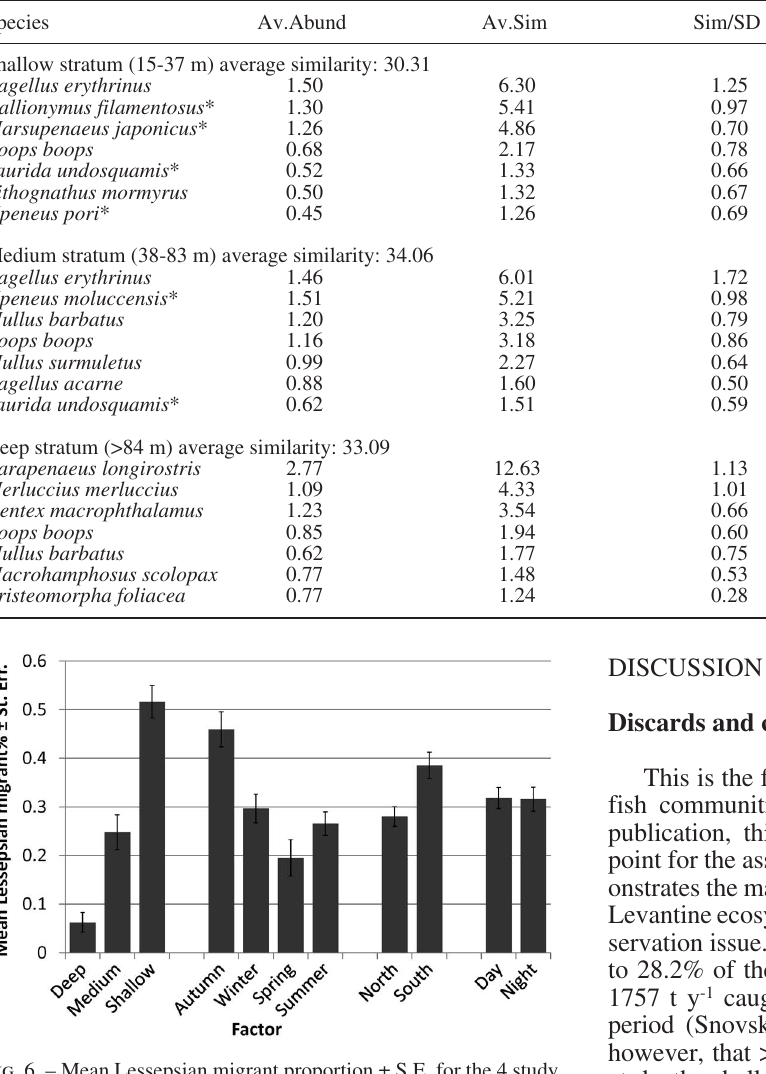
Fig . 6. – Mean Lessepsian migrant proportion ± S.E. for the 4 study factors in the 324 haul